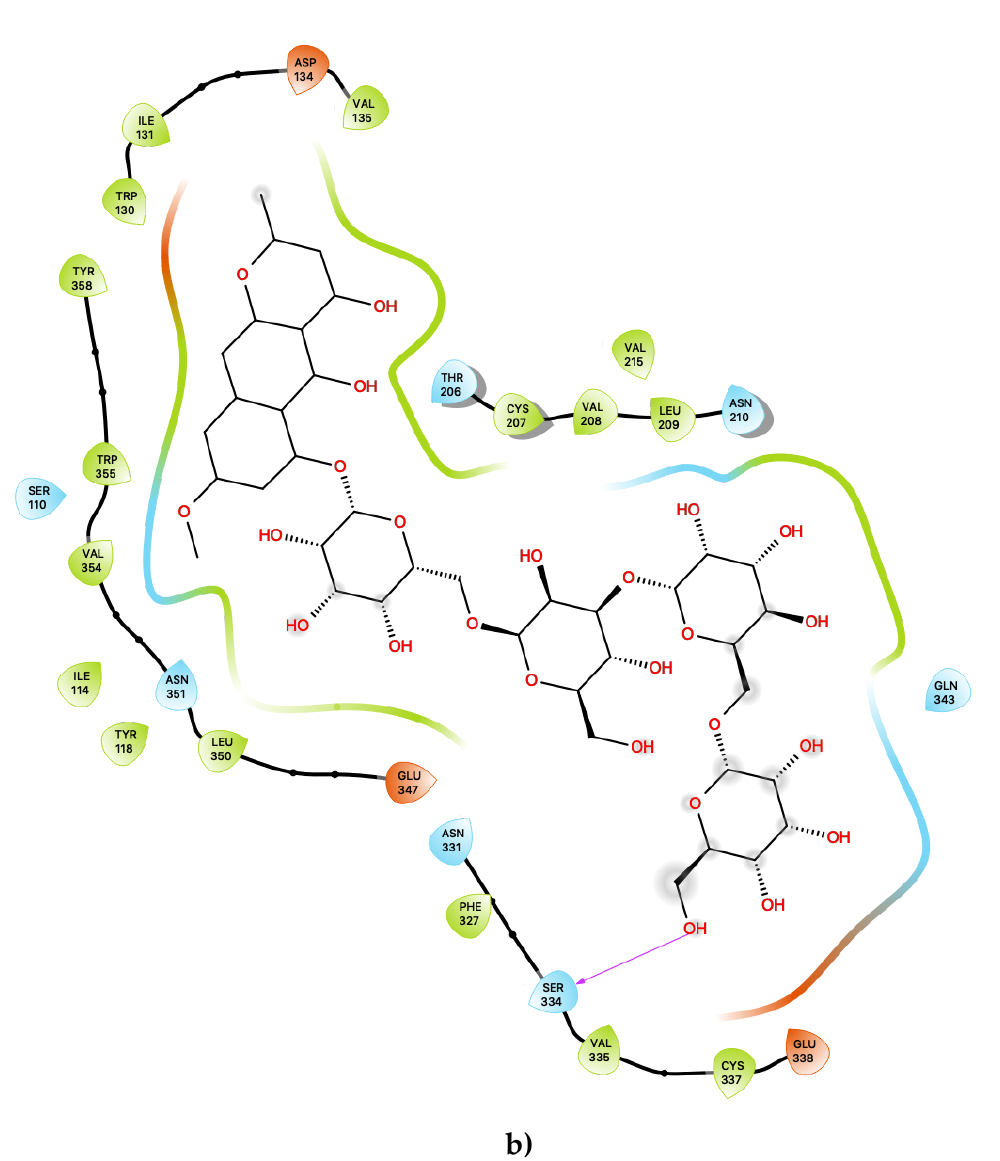
Figure 2. ( a ) Ligand-protein interaction of c34-S1 and ( b ) c49-S1. Arrow indicates hydrogen bond. Grey halos indicate solvent-exposed atoms.